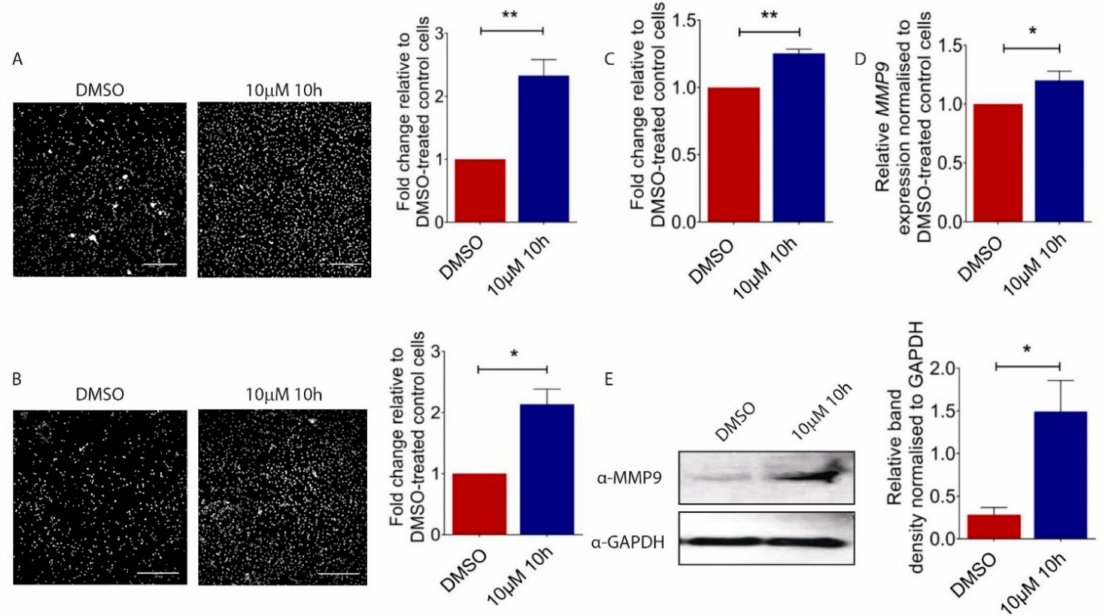
Figure 2. Effect of 10h on B16/F10 cell migration and invasion. ( A ) Representative images and quantitative analysis of migrated B16/F10 cells after 10h and DMSO treatments. ( B ) Representative images and quantitative analysis of invading B16/F10 cells after respective treatments. Scale bar: 200 µ m. ( C ) Quantitative analysis of B16/F10 cells attached to fibronectin coated plate normalised to 0.05% DMSO-treated controls. ( D ) MMP9 gene expression in 10 µ M 10h or DMSO-treated B16/F10 cells as determined by real-time quantitative PCR analysis. ( E ) Representative Western blot and densitometry analysis of MMP9 in 10 µ M 10h or 0.05% DMSO-treated control B16/F10 cells. All images are representative. Data are presented as the mean ± s.e.m of three independent experiments. Statistical analysis was performed using two-tailed, unpaired student’s t -test; * p < 0.05, ** p <